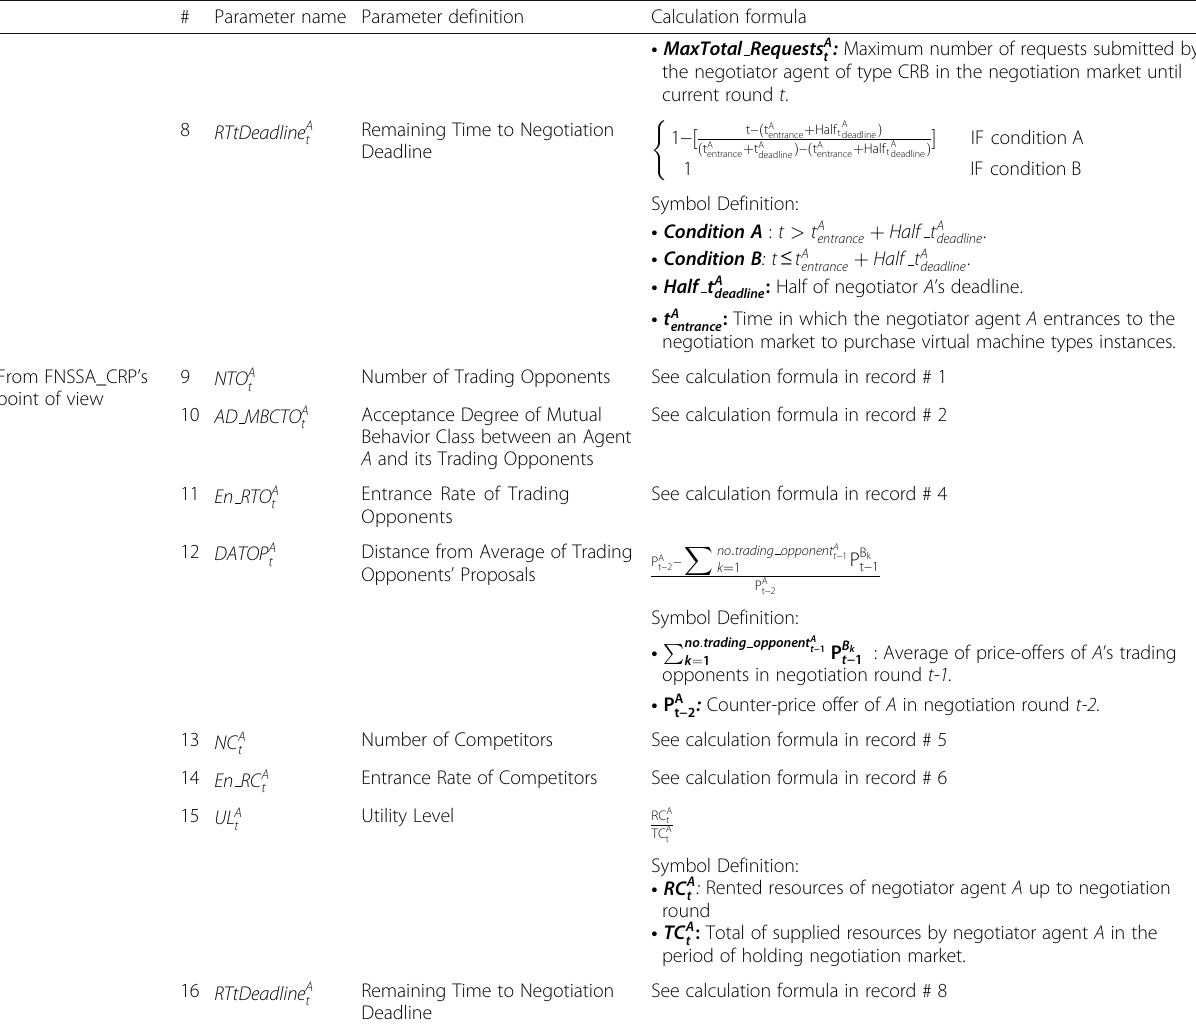
Table 1 Parameters that are used to model critical condition of the cloud trading market from both FNSSA_CRP ’ s and FNSSA_CRB ’ s points of view and their calculation formulas